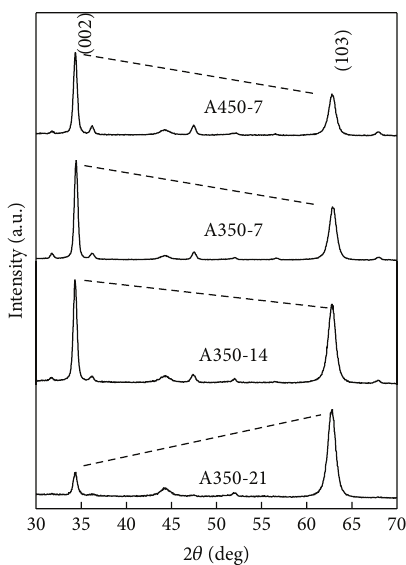
Figure 2: XRD patterns of the different AZO films.